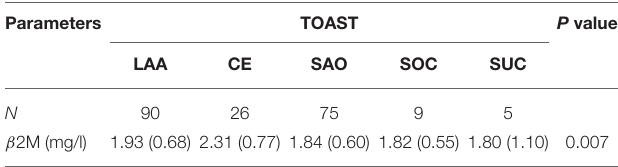
TABLE 5 | Correlation analysis between β 2-microglobulin ( β 2M) and Trial of ORG 10172 in Acute Stroke Treatment (TOAST) subtype ( N = 205).